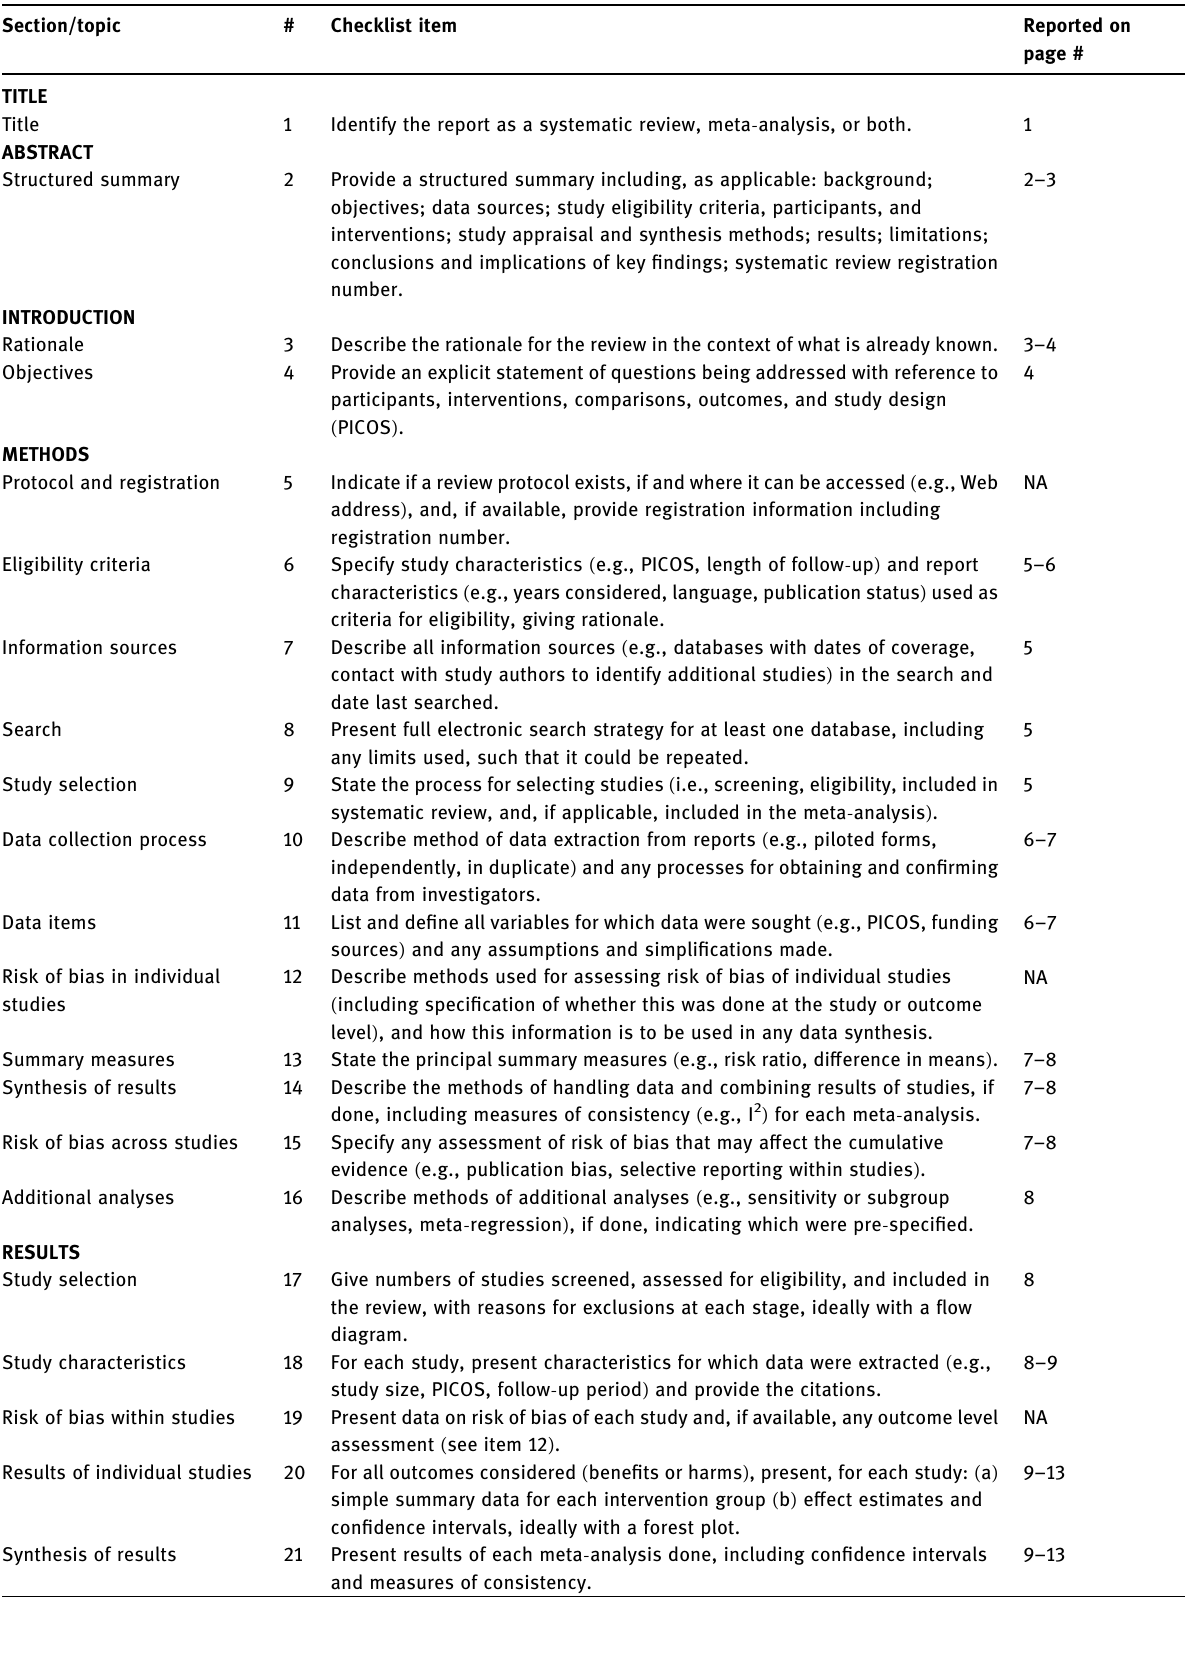
Table S2: PRISMA 2009